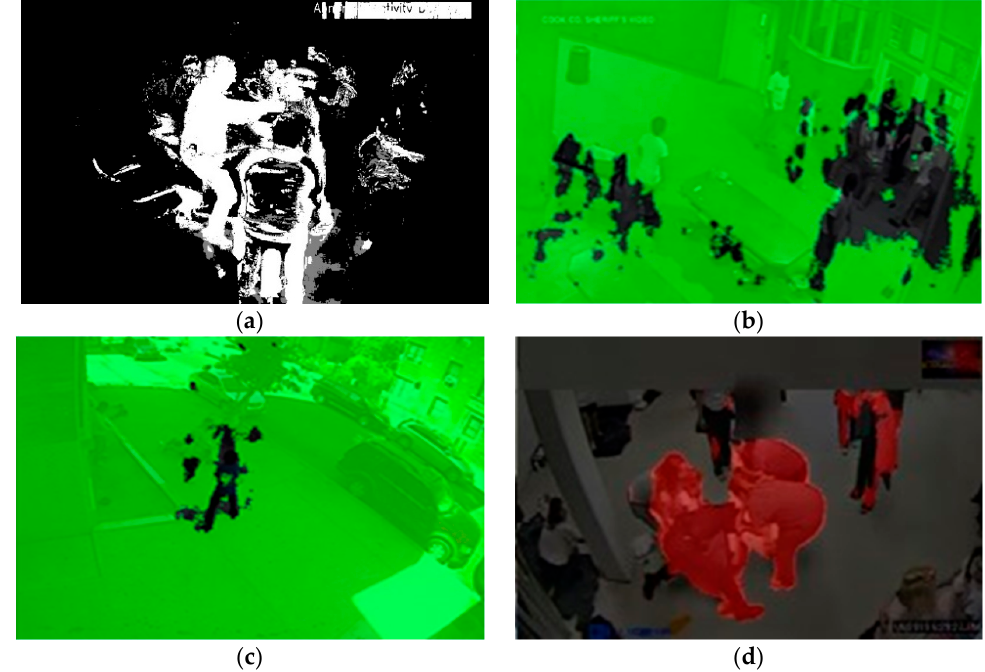
Figure 3. Comparison of four image segmentation algorithms. ( a ) The Gaussian, ( b ) The ENET, ( c ) The Mediapipe, ( d ) The DeeplabV3plus.